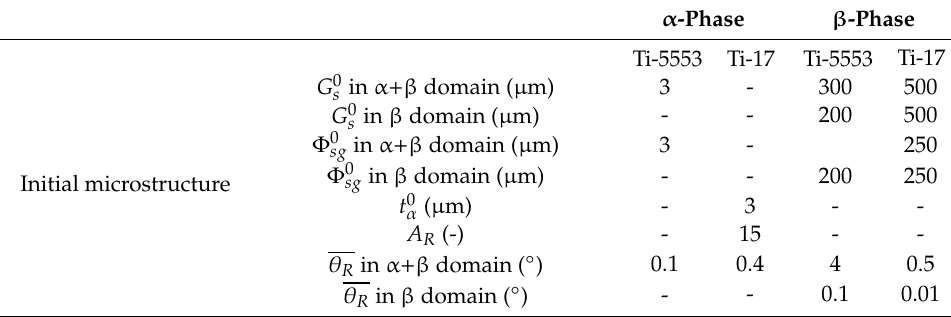
Table A1. Measured microstructural parameters corresponding to the initial microstructure used in the developed